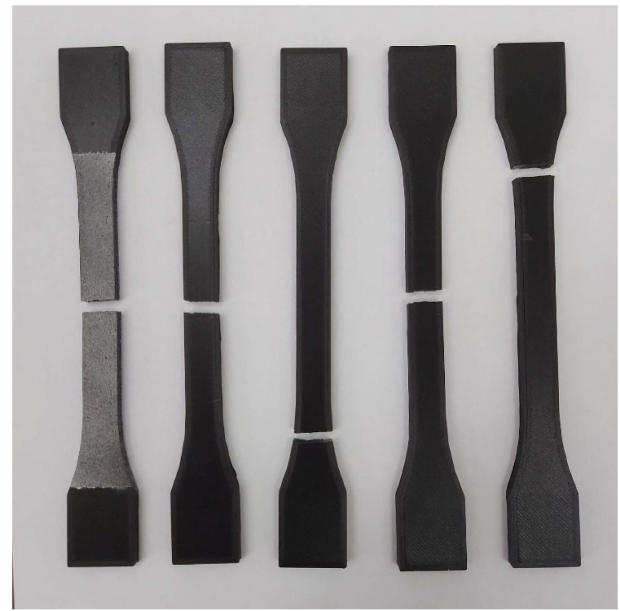
Figure 12. Failure mode of the XZ1 specimens.